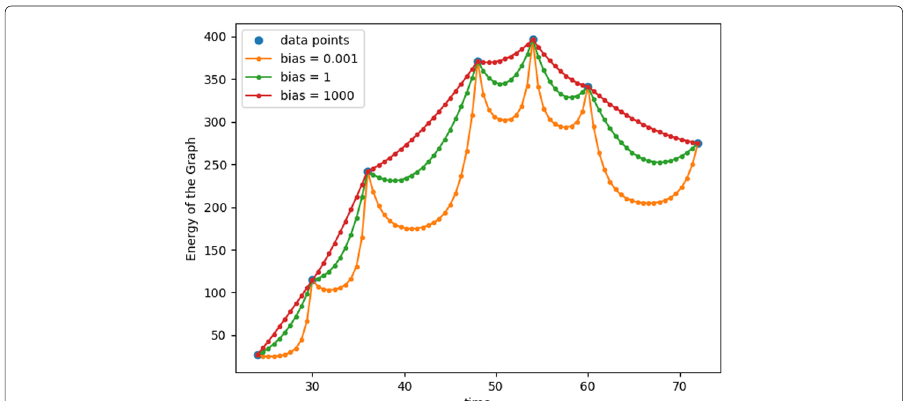
Fig. 12 Graph energy in interpolated proteomics network, LE geodesic with varying bias values. Using a bias value of 1.0 essentially produces an average of the geodesic and linear interpolations; a bias value of 1000 produces results similar to the linear interpolation, and a bias value of 10 − 3 produces results similar to those obtained with a bias value of 10 − 6